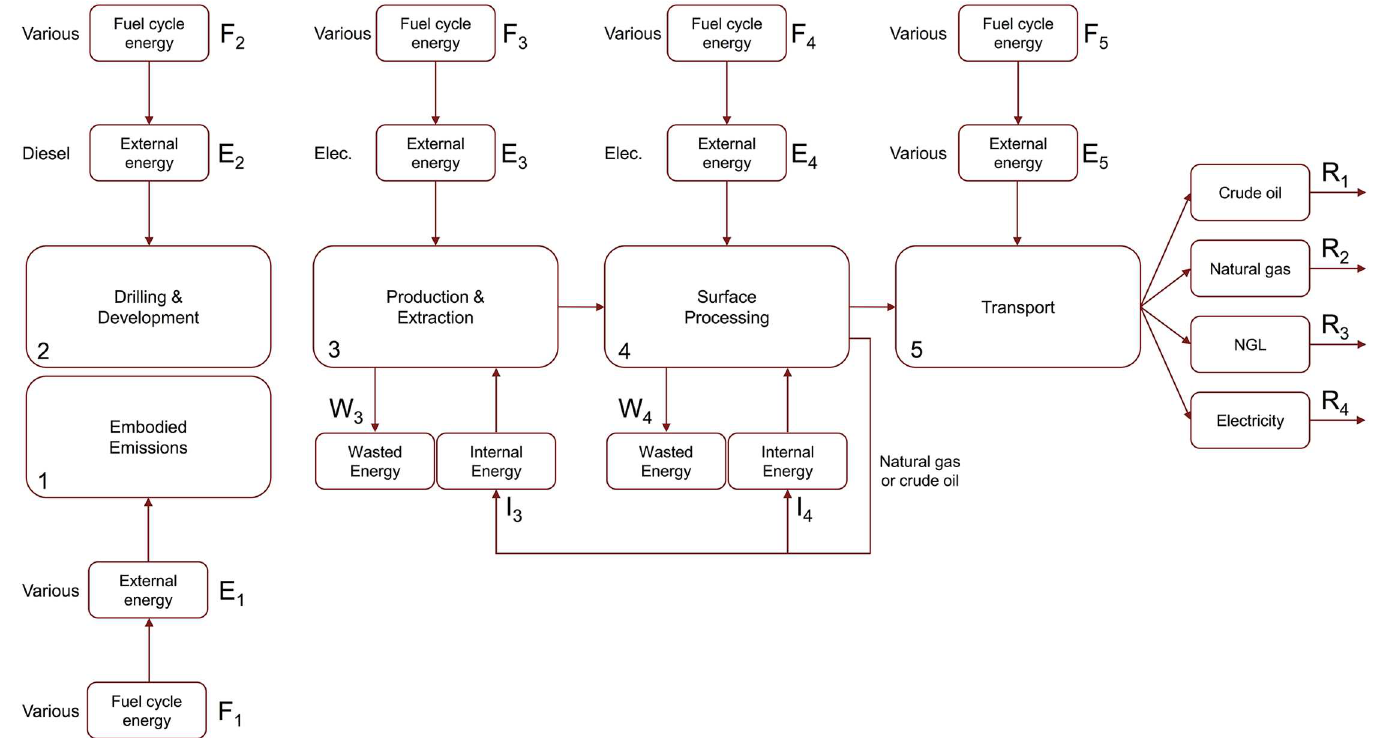
Fig 1. Schematic of OPGEE production processesand related energy flows used to calculate NER and EER values. Figure adaptedfrom Brandt et al. [8].